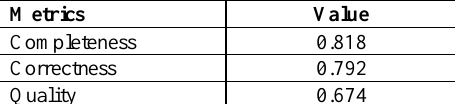
Table 2. The Completeness, Correctness and Quality